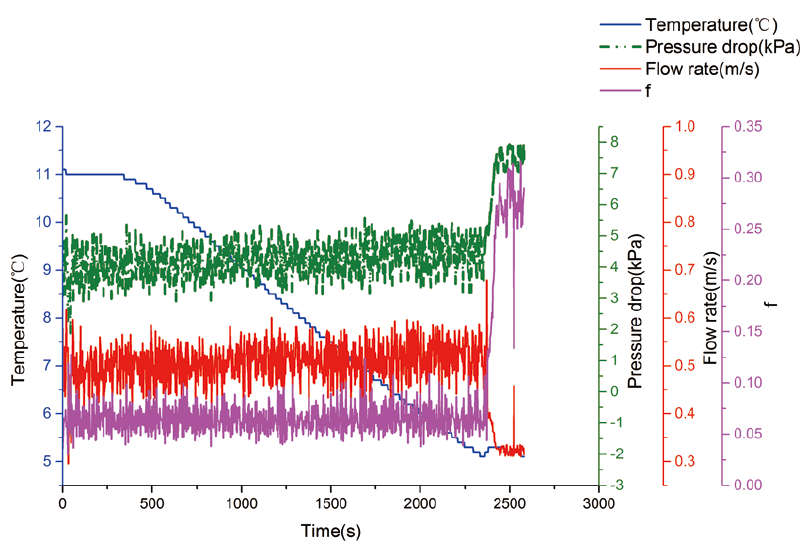
Figure 7. Temperature, flow rate, differential pressure and friction versus time for a water cut of 60%.